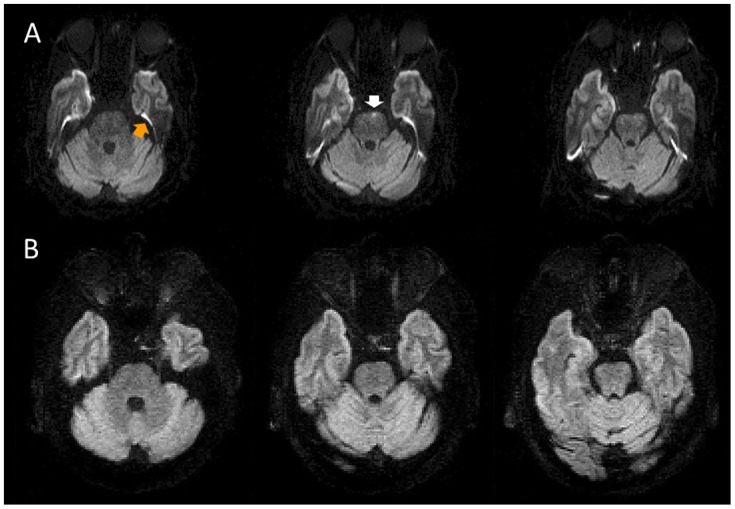
Artifacts on the DWI sequences.A) Example of artifacts on the high-resolution EPI-DWI (three consecutive slices shown). A typical susceptibility artifact is visible on the EPI-DWI (orange arrow)–note that such artifacts were ignored by the raters and are not the focus of this study. An intraparenchymal hyperintensity in the left pons (white arrow) is seen on a single slice. B) Neither of these artifacts is present on the STEAM-DWI.